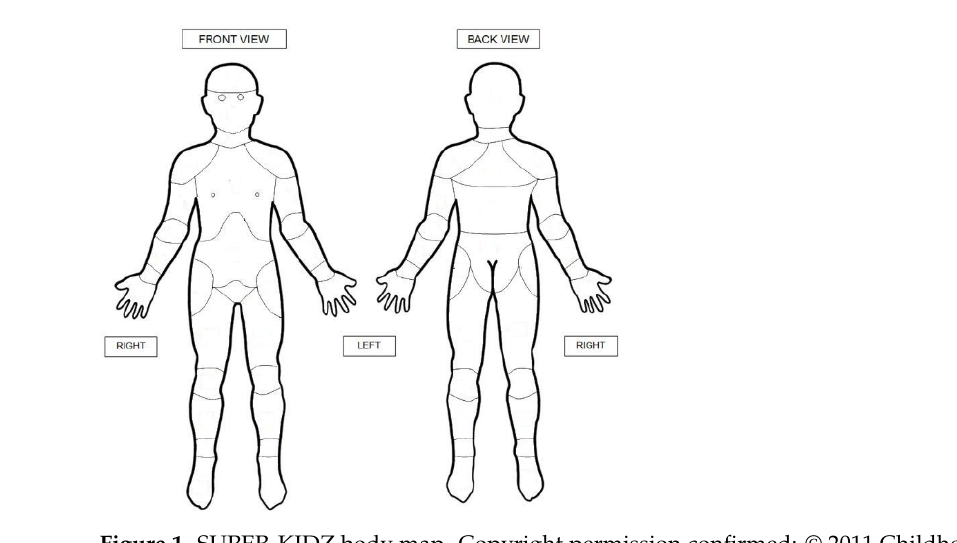
Figure 1. SUPER-KIDZ body map. Copyright permission confirmed: © 2011 Childhood Arthritis and Rheumatology Research Alli-ance (CARRA). www.carragroup.org. divided into nine regions: lower limbs, upper limbs, chest, abdomen, head, neck, lower back, middle back, and upper back. Thoracolumbar back pain (TLBP) was defined as pain in the lower and/or middle back. Lower limbs contained the right and left foot, ankle, shin, Table 1. Summary of questionnaire content (paper or